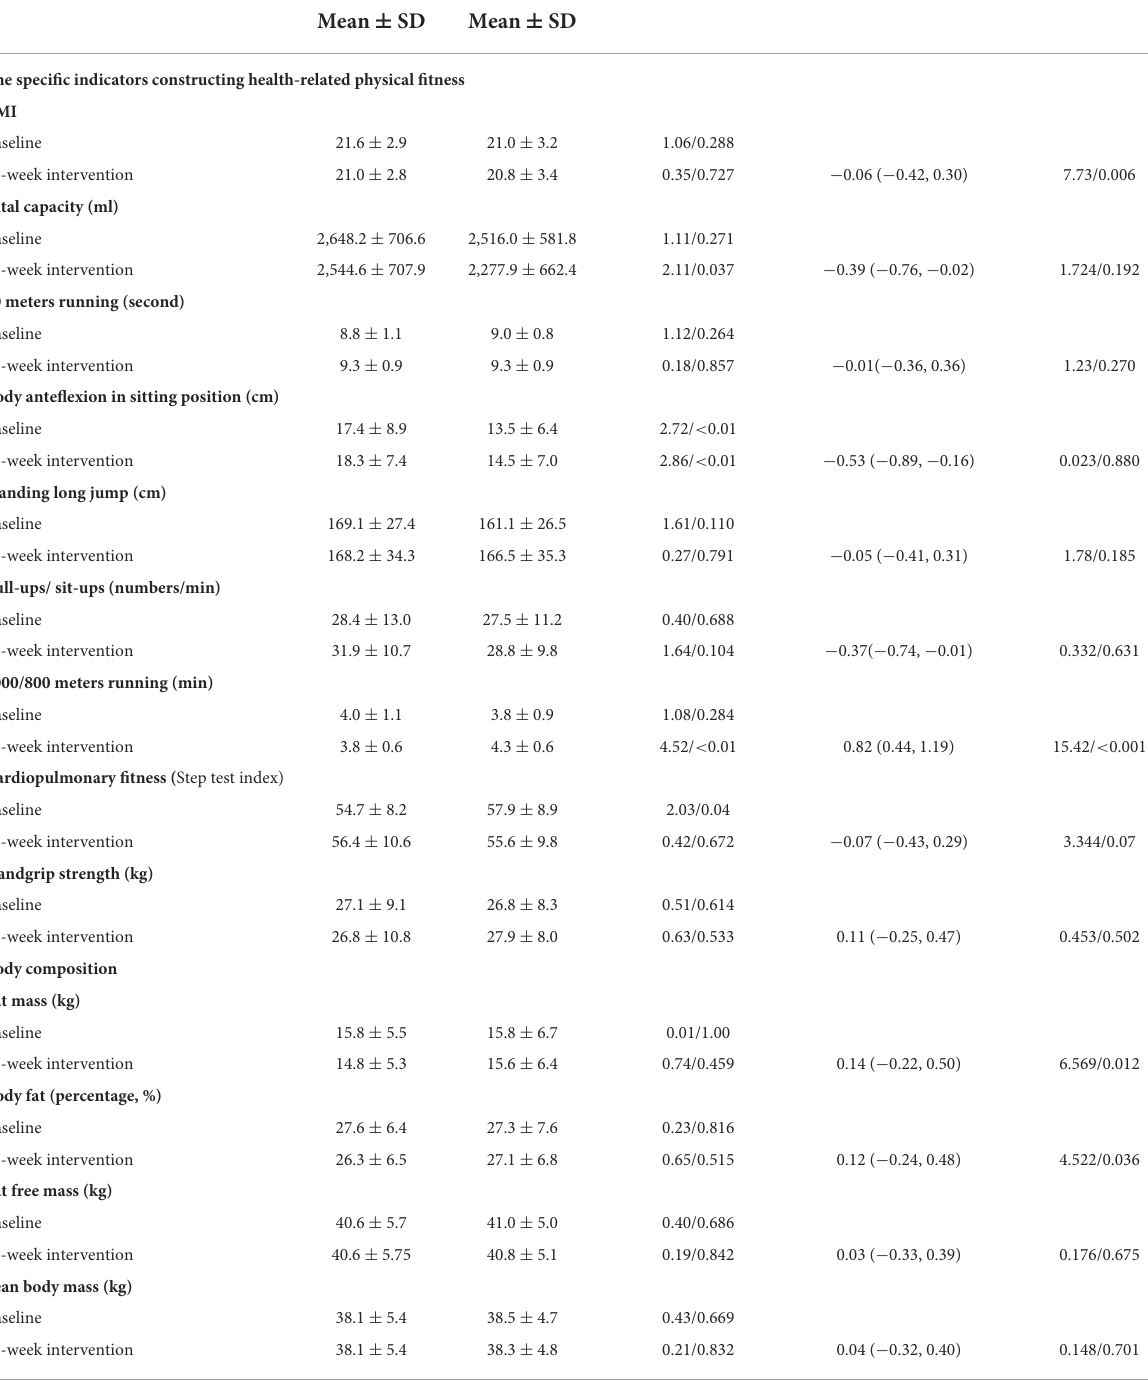
CG Comparison Between-group Time × group ( n = 61) ( n = 57) between groups effect size interaction t/ P -value Cohen’s d 95% CI F /P -value Mean ± SD Mean ±